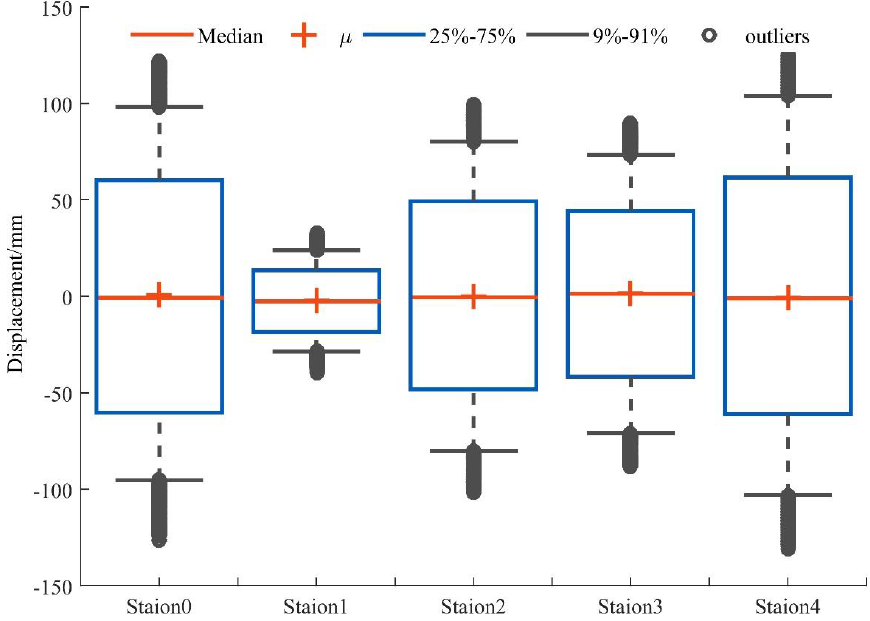
Figure 5. The box plot of station 0~4 in the east direction.